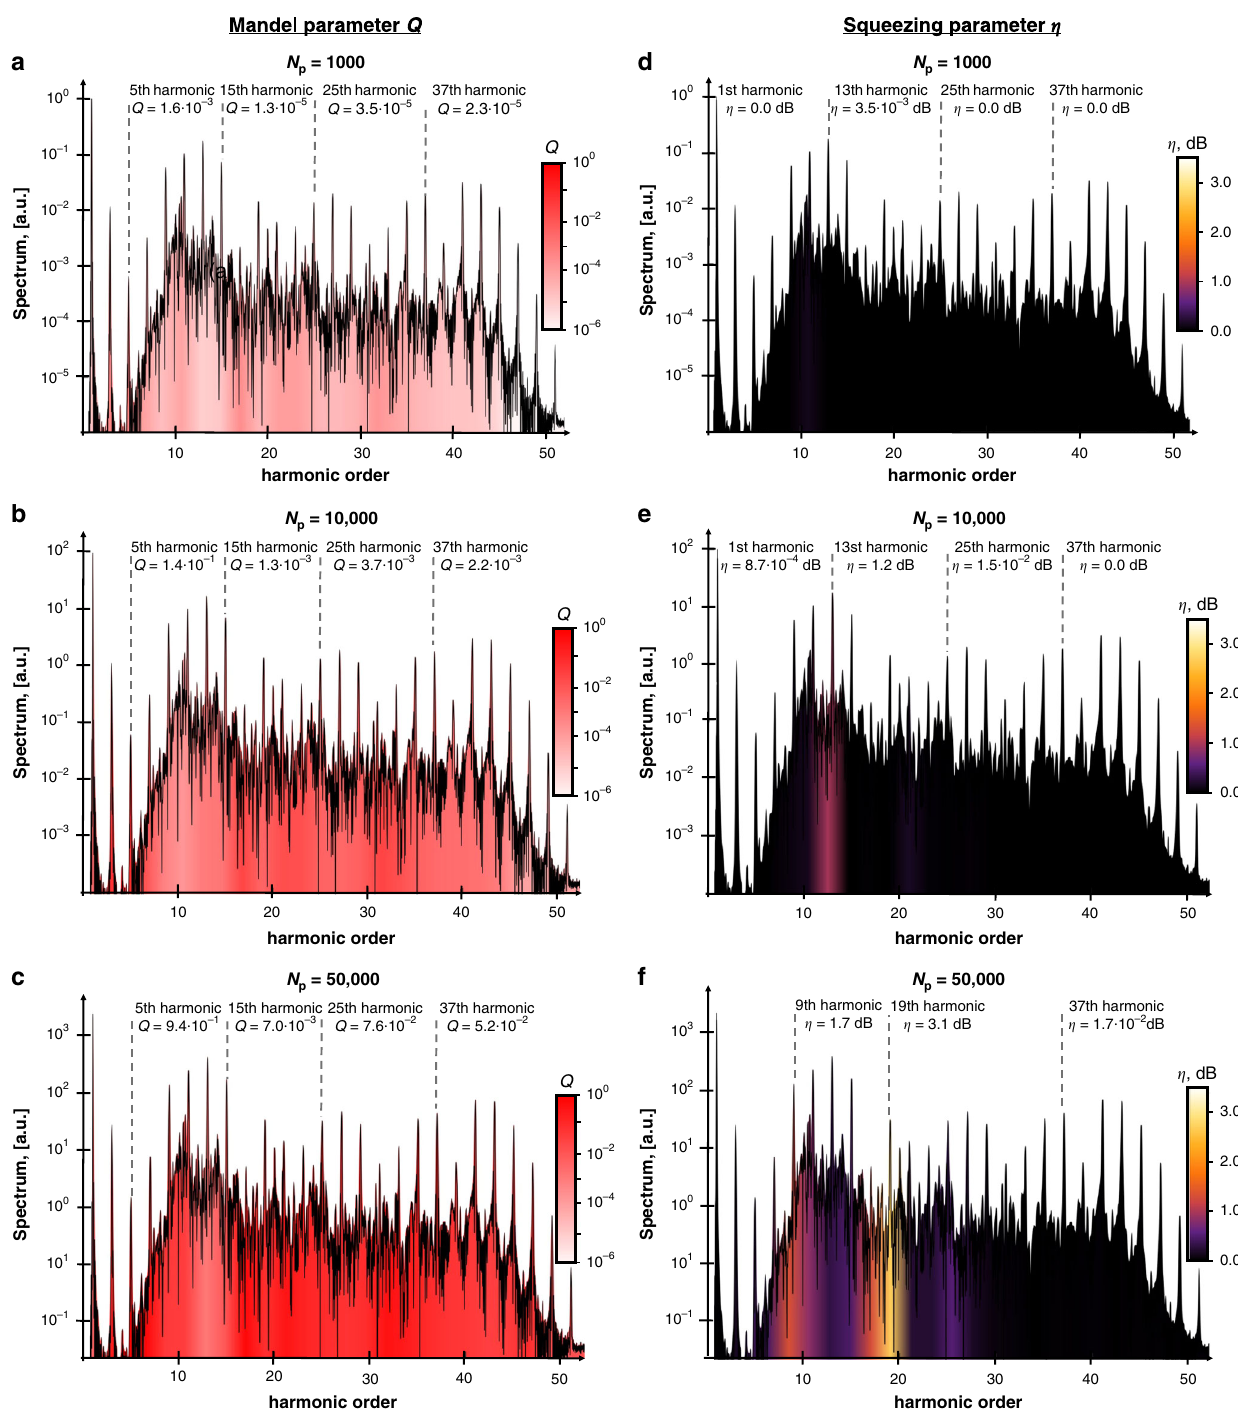
Fig. 4 Photon statistics of HHG in the many-atom regime. a – c present the Mandel parameter Q by the intensity of the red color for different numbers of phase-matched atoms N p = 10 3 , 10 4 , and 5 × 10 4 respectively. d – f present the squeezing η for the same numbers of phase-matched atoms. With an increase in the number of phase-matched atoms, the quantum properties of the emitted light become larger. All the parameters of the numerical calculations are the same as in Fig.